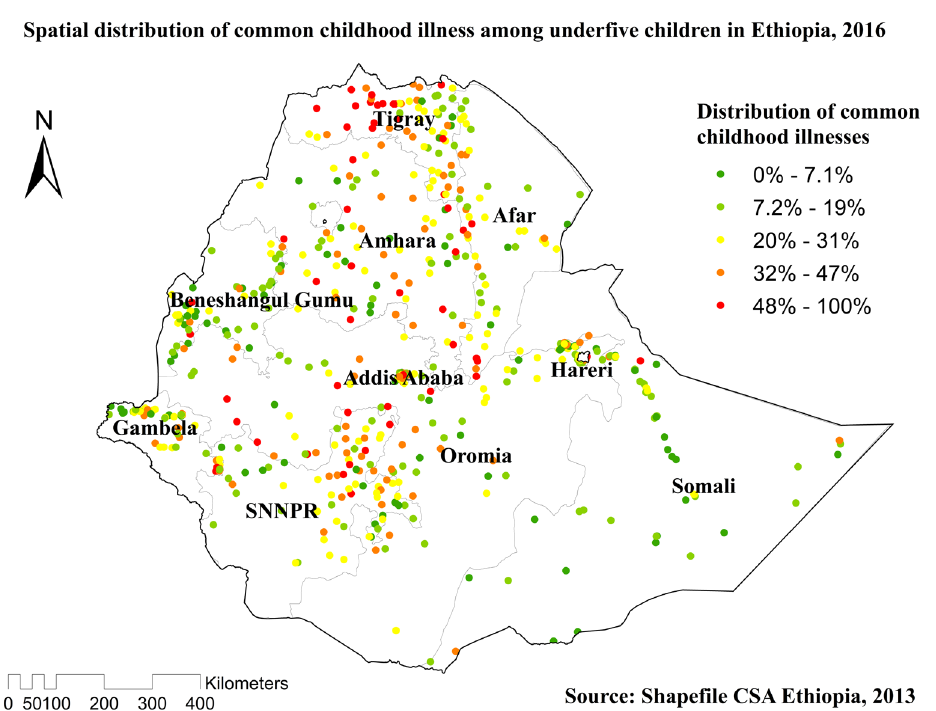
Figure 3. Spatial distribution of common childhood illnesses among under-five children in Ethiopia, 2016